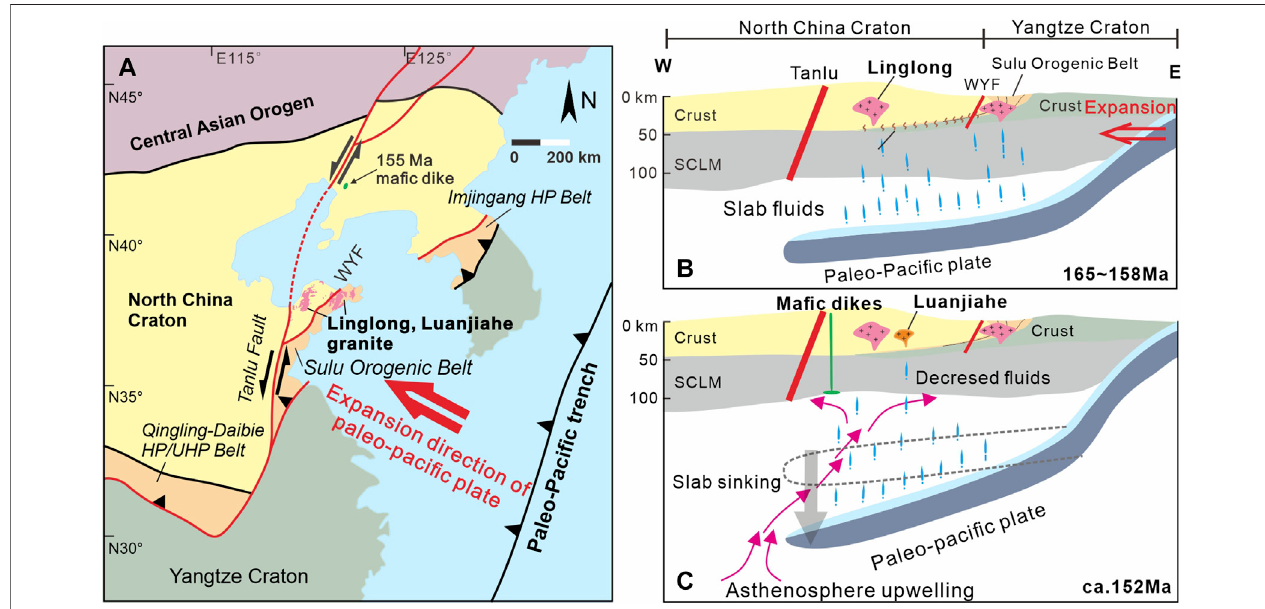
FIGURE 15 | (A) Tectonic map showing the major continental blocks, suture zones, and fault systems in eastern China and the subduction direction of the Paleo- Paci fi c plate during the Late Jurassic (B – C) Geodynamic processes for the formation of Linglong and Luanjiahe granites. See texts for the explanation.